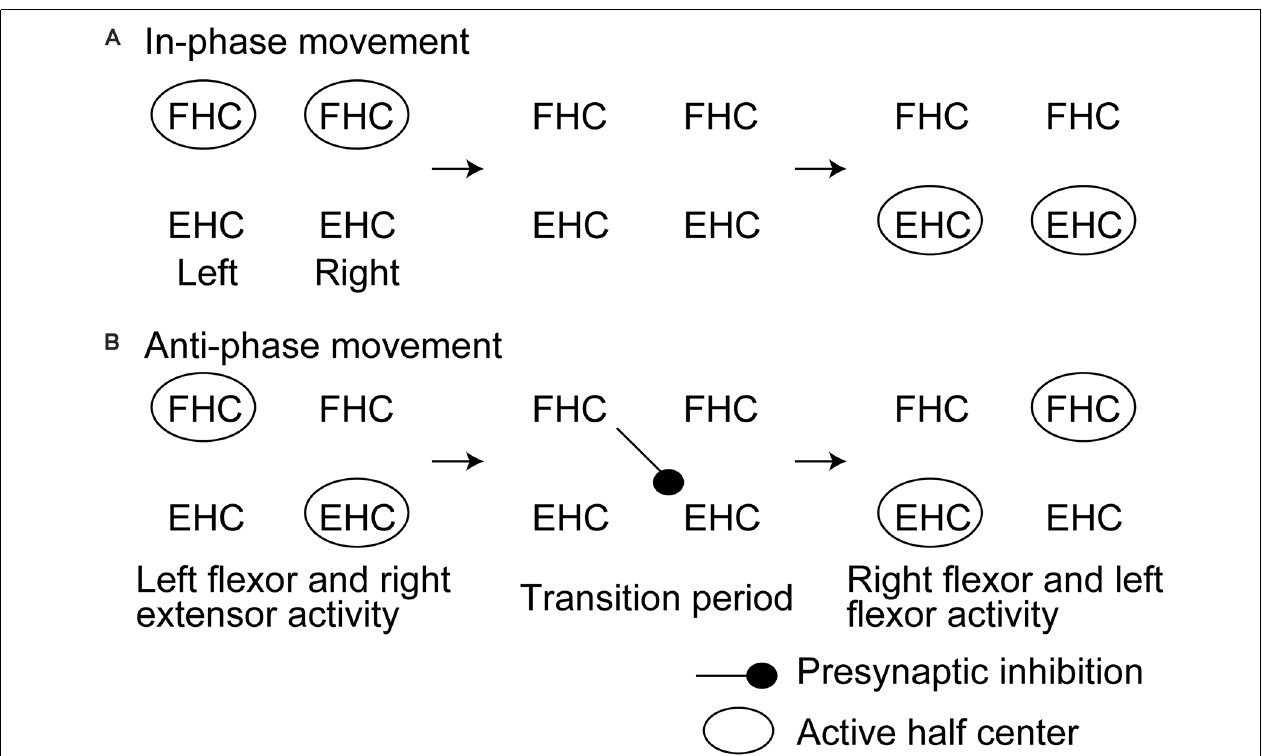
FIGURE 3 | Hypothesized time course of the half center activities and crossed inhibition during in-phase (A) and anti-phase bilateral rhythmic ankle movement (B) proposed by Hiraoka and colleagues. This model is discussed in the text. FHC, flexor half center; EHC, extensor half